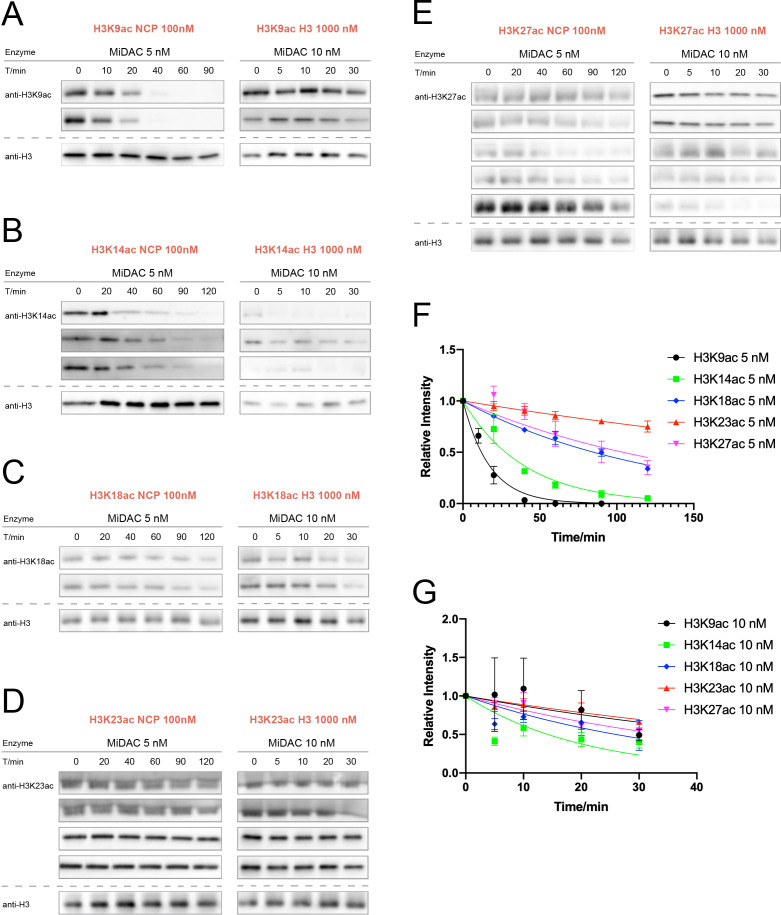
MiDAC (MiDEAS-DNTTIP1-HDAC1) activity assay over nucleosomes or histones with acetylation at different sites.(A) H3K9ac (n = 2 for nucleosome assay; n = 2 for histone assay), (B) H3K14ac (n = 3 for nucleosome assay; n = 3 for histone assay), (C) H3K18ac (n = 2 for nucleosome assay; n = 2 for histone assay), (D) H3K23ac (n = 4 for nucleosome assay; n = 4 for histone assay), (E) H3K27ac (n = 5 for nucleosome assay; n = 5 for histone assay). (F) Curve fitting for nucleosome kinetics with 5 nM MiDAC labeled in the graph, and G. Curve fitting for histone kinetics with 10 nM MiDAC labeled in the graph.